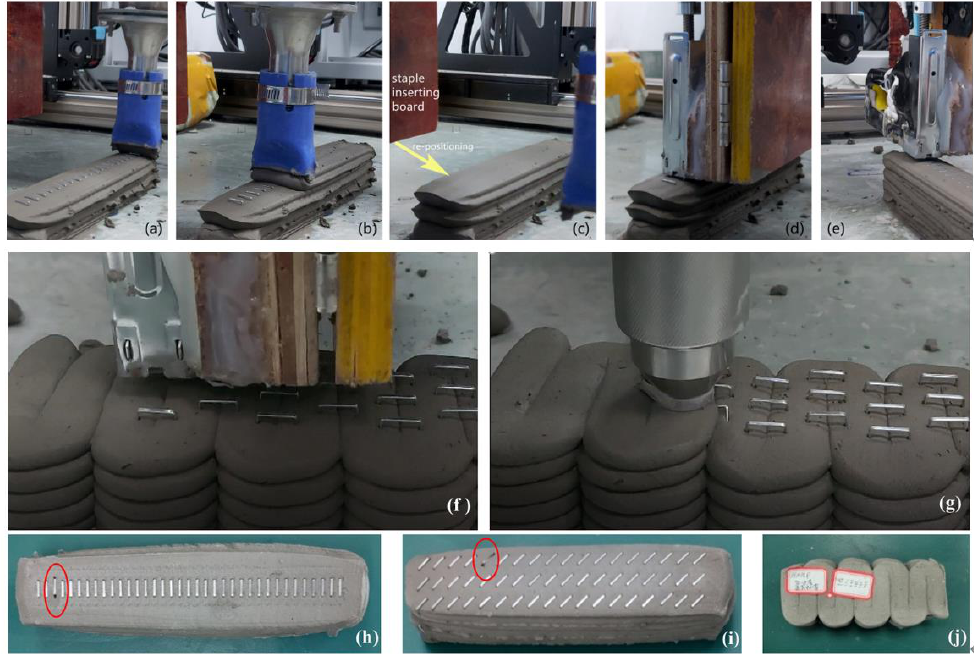
Figure 9. Fabricating processes with the 3DCP-SIA and typical samples. ( a ) the mortar extruder was ready to print, ( b ) mortar printing in process, ( c ) SIA repositioning in process, ( d ) staple inserting in process, ( e ) staple insertion was about to finish, ( f ) staple inserting to a IL sample, ( g ) mortar printing to cover the inserted staples, ( h ) a stapled IR sample with a failed staple in red circle, ( i ) a IR sample with three rows of staples, a failed staple in red circle, and ( j ) a printed and stapled IL